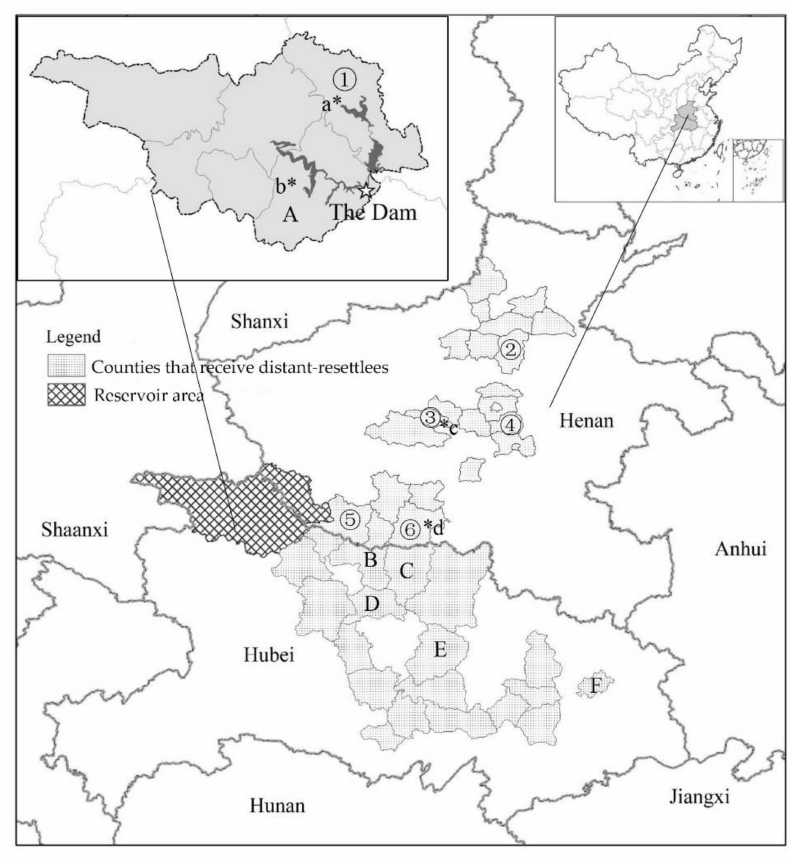
Figure 1. Spatial distribution of the research areas. Investigated counties ( 1 (cid:13) – 6 (cid:13) are in Henan Province, and A–F are in Hubei